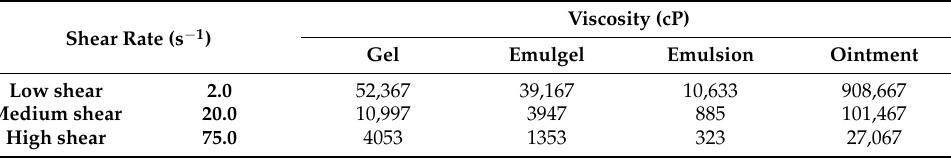
Table 3. Low, Medium, and High Shear Viscosity Values for the semi-solid formulations containing diclofenac sodium